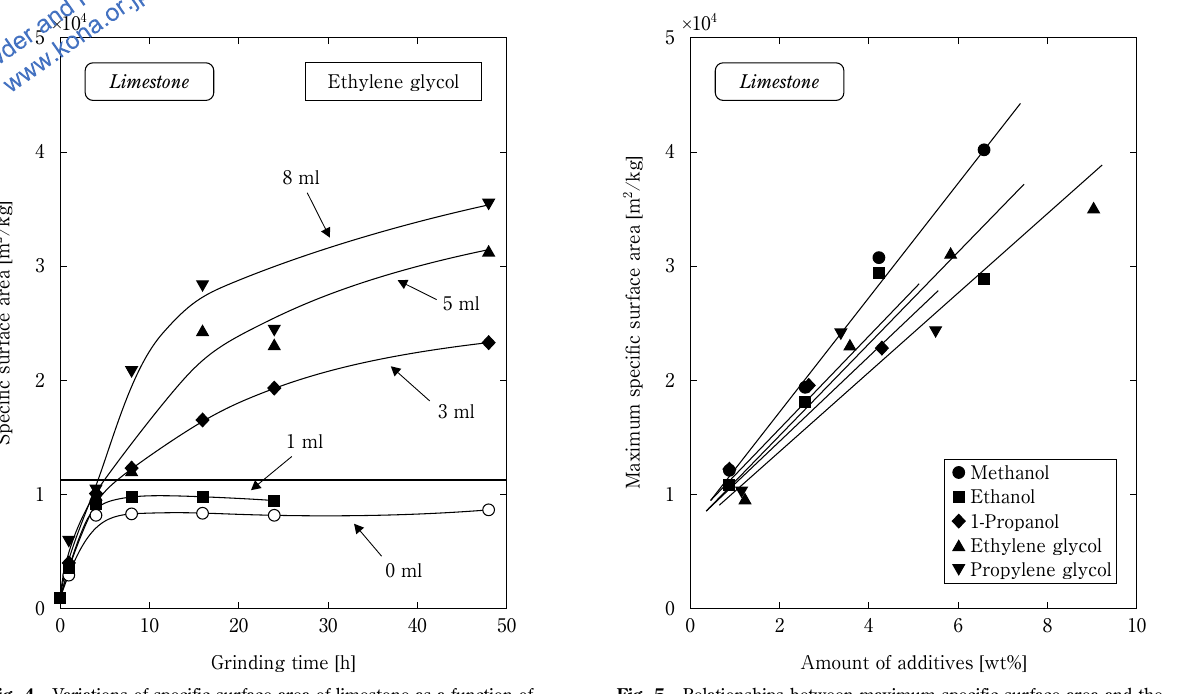
Fig. 5 Relationships between maximum specific surface area and the amount of additives.